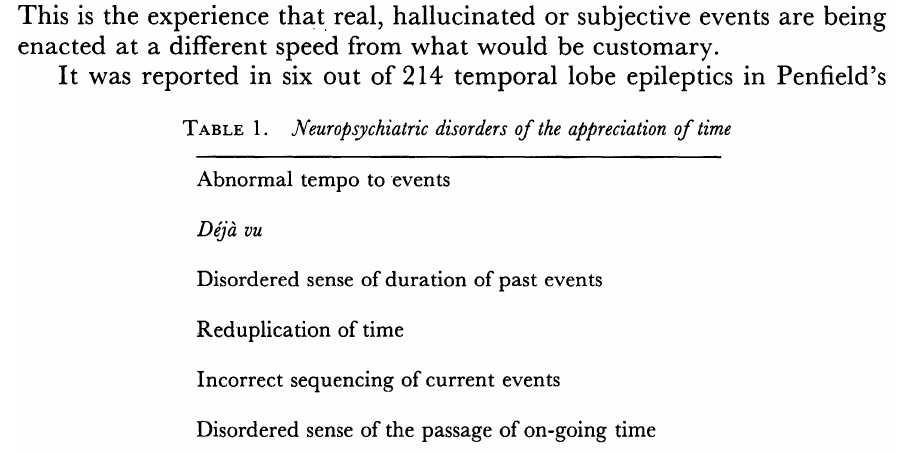
TABLE 1. Neuropsychiatric disorders of the appreciation